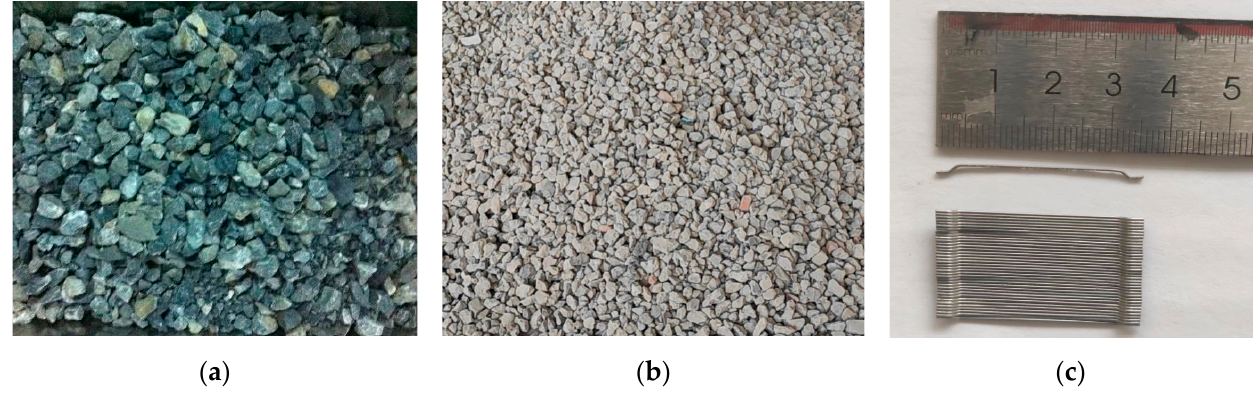
Figure 1. The appearance of materials: ( a ) Natural coarse aggregate, ( b ) recycled coarse aggregate, ( c ) steel fibers. Table 1. Physical properties of